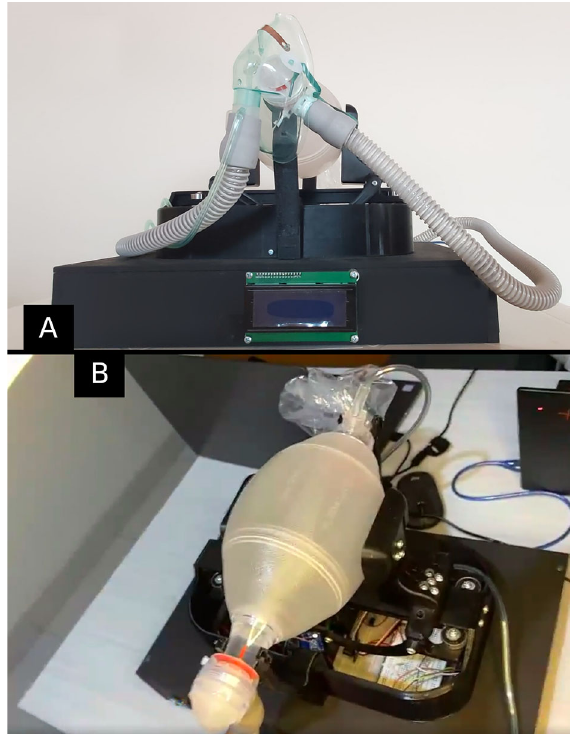
Figure 2. Front (panel A) and superior (panel B) views of the mechanical